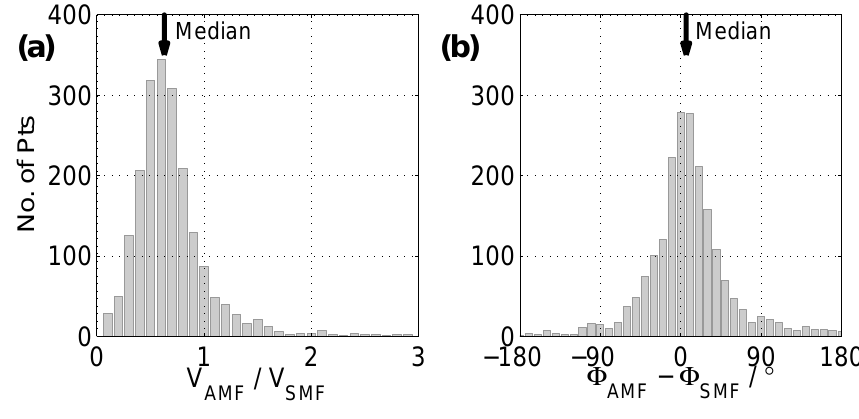
Fig. 7. Histogram of the ratios of the wind speeds (a) and differences of the wind directions (b) between Andenes MF and Saura MF radars in the altitude range of 82 and 86km (July